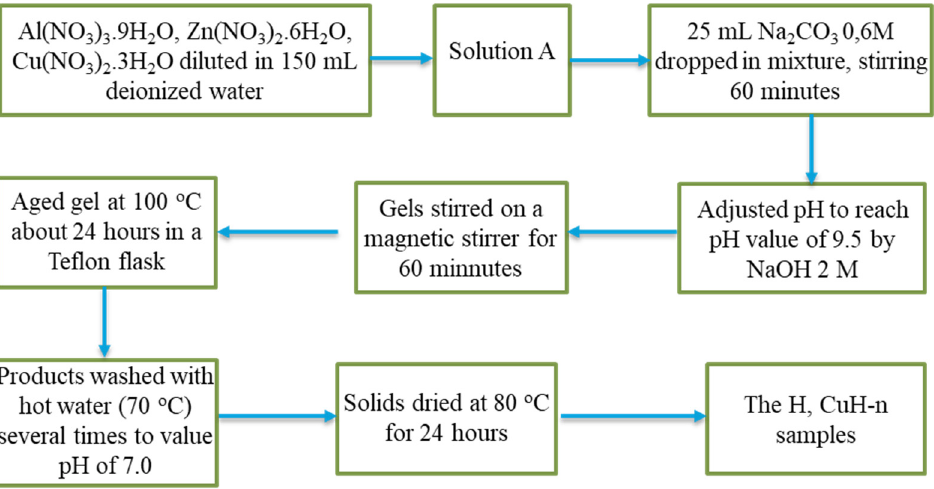
Figure 1. The synthesis stages of 5 material samples H, CuH–2.0, CuH–2.5, CuH–3.0, and CuH–3.5.